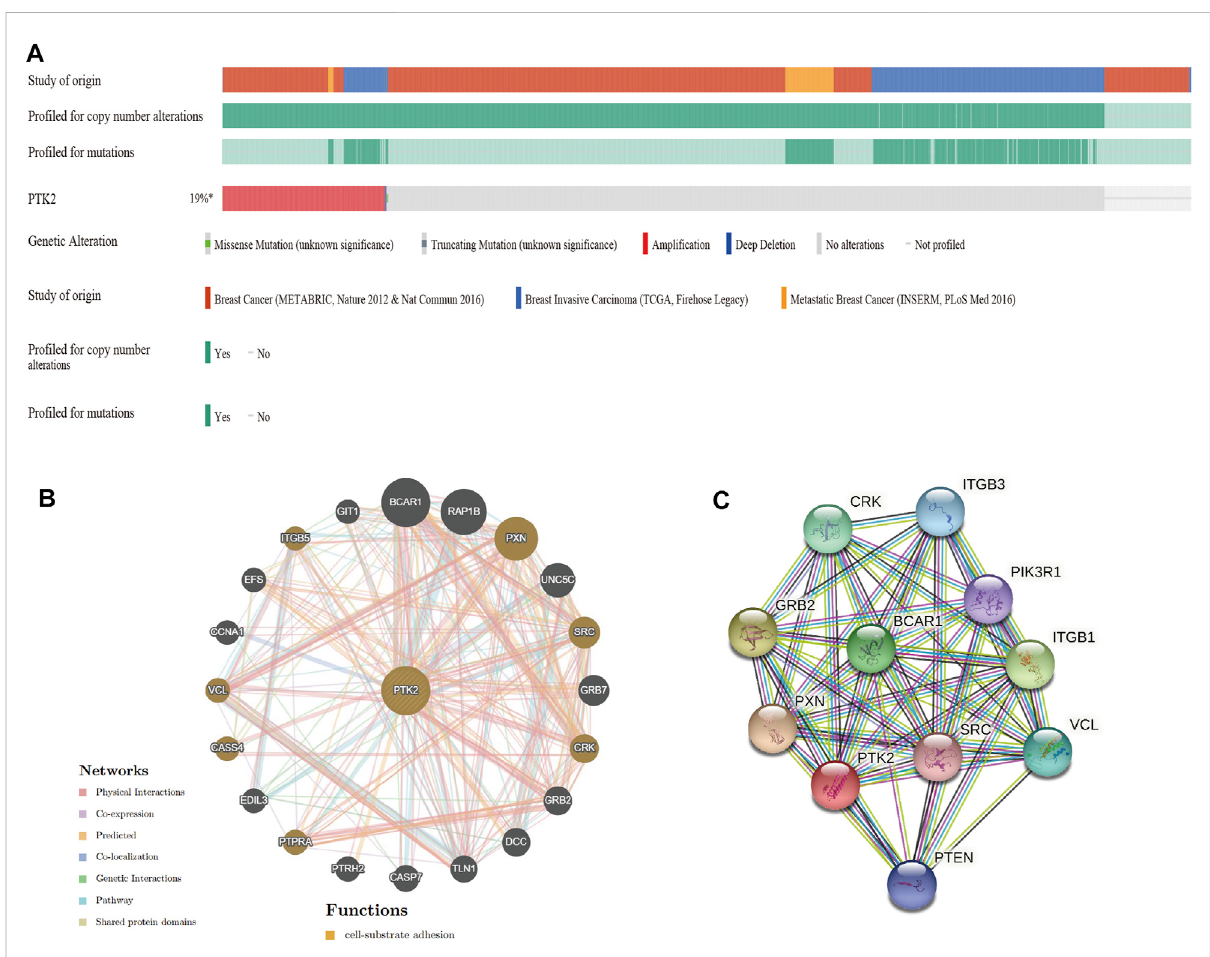
FIGURE 4 Genomic alterations of PTK2 in breast cancer. (A) Overview of genomic alterations of the PTK2 in breast cancer using OncoPrint schematic. (B) Gene – gene interaction network of PTK2 was constructed using GeneMania. (C) PPI network of PTK2 was generated using